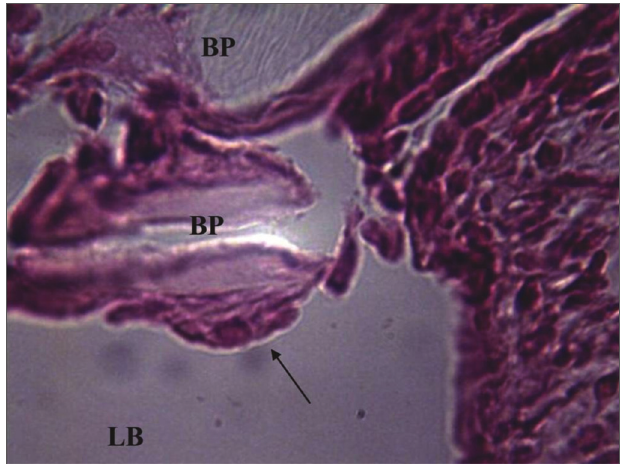
Figura 5. Grupo experimental com 8 semanas - Fotomicrografia da membrana timpânica espessada na sua porção em contato com